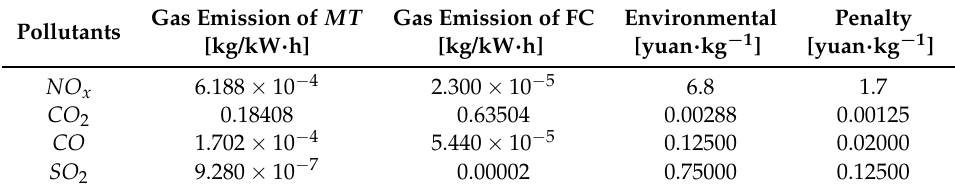
Table 3. Pollutant gas emissions and treatment cost parameters.